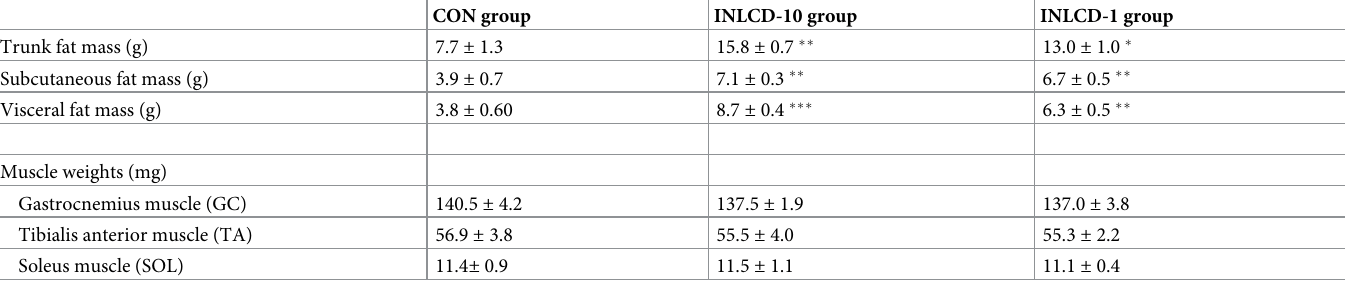
Table 2. Body composition of